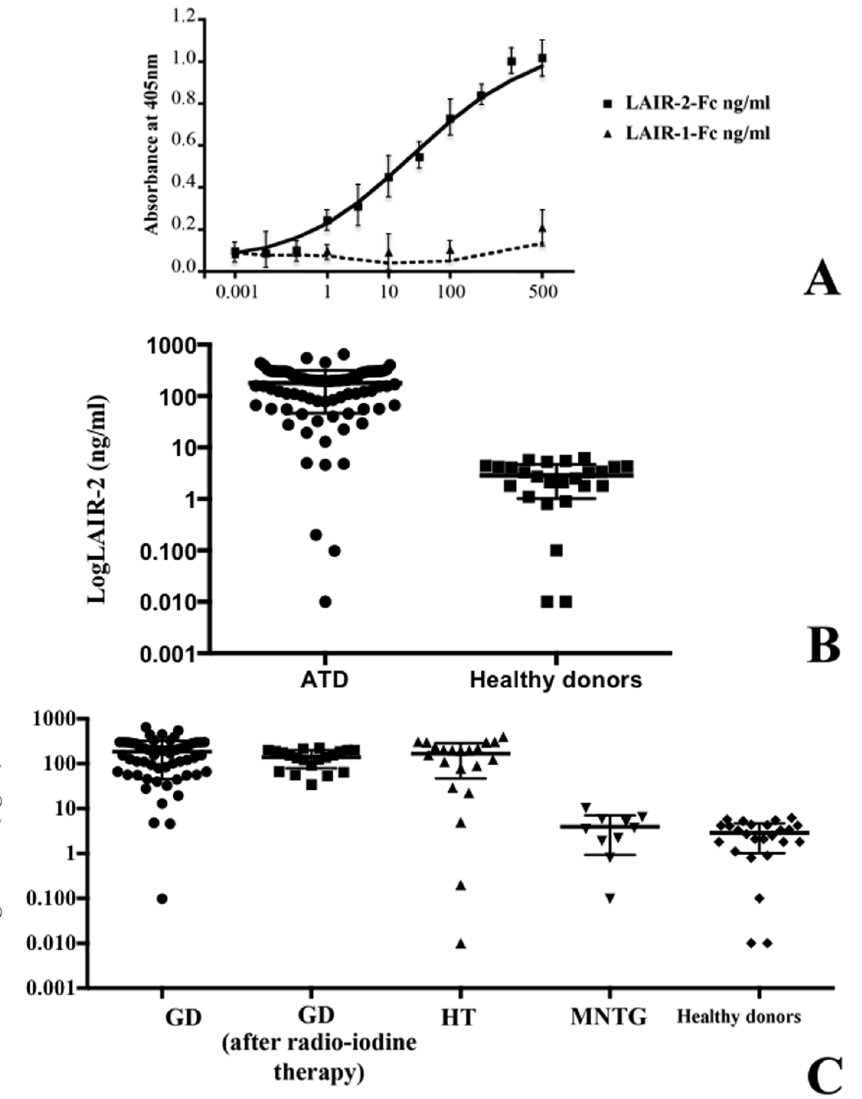
Figure 1. LAIR-2 is found in serum of patients with ATD and healthy donors but its level correlates with autoimmune disease. A, A calibration curve of LAIR-2 ELISA was performed. The plotted OD values were obtained with serial dilution of LAIR-2-Fc protein. In addition, no relevant cross-reaction with soluble LAIR-1-Fc was detectable. A representative experiment of three is shown. Bars represent standard deviation. B, Serum LAIR-2 is measurable both in healthy donors and patient with ATD, otherwise ATD had far higher circulating LAIR-2 levels. C, LAIR-2 ELISA on 59 sera of GD, 20 of GD patients one month after radio-iodine treatment, 21 HT patients, 10 of patients with MNTG and 25 healthy donors. Samples were diluted 1:10 and tested in triplicate (deviation between triplicates , 10%; detection limit 0.1 ng/ml).